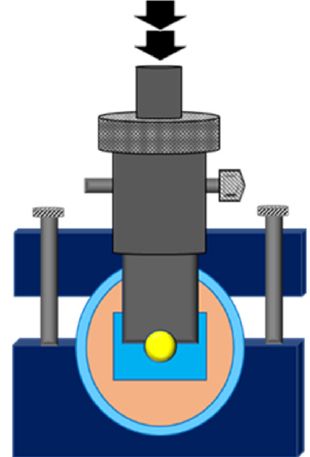
Figure 2. Illustration of notched-edge shear bond strength test.